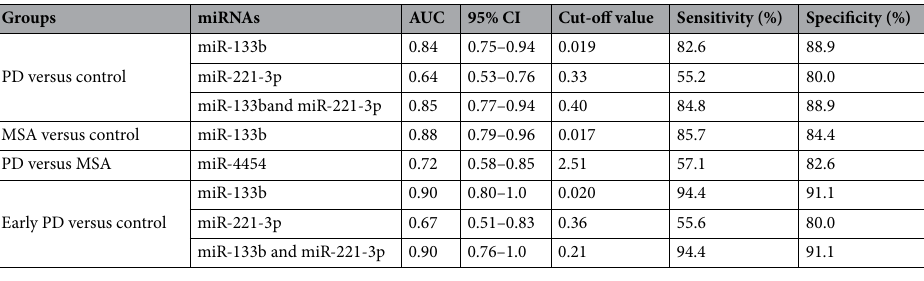
Table 4. Diagnostic power of miRNAs to discriminate among PD, MSA and healthy controls (measured by ROC curve analyses). PD, Parkinson’s disease; MSA: multiple system atrophy; AUC, area under the curve; CI, confidence interval.